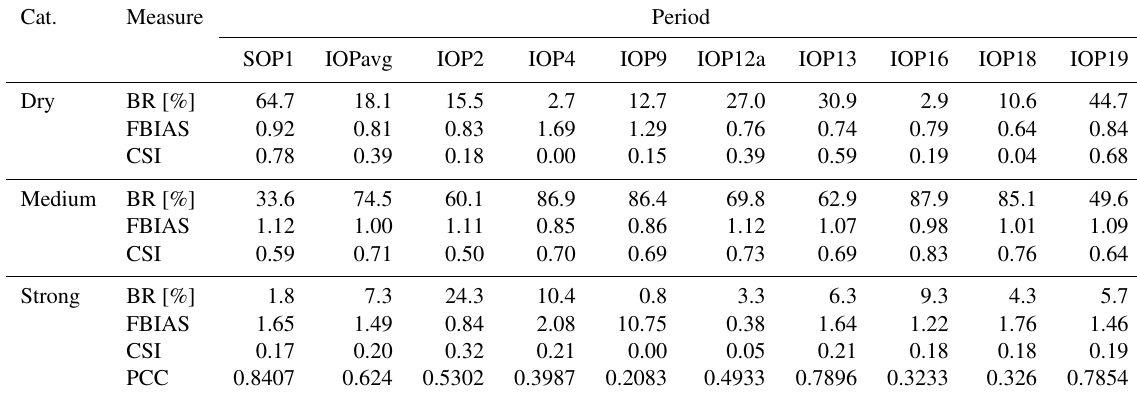
Table 4. Same as Table 2 but verification measures are calculated for ALADIN 2km model.